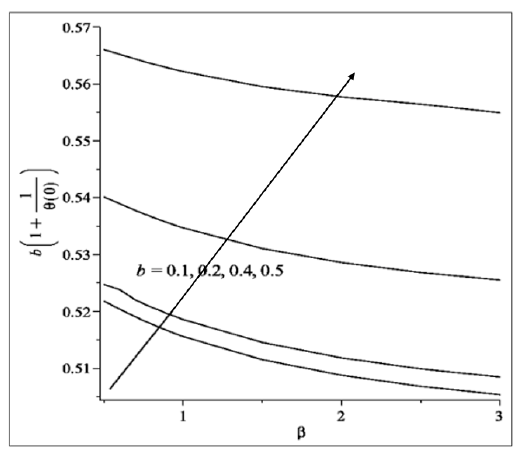
Figure 17. Various values of b on Nusselt number and β .